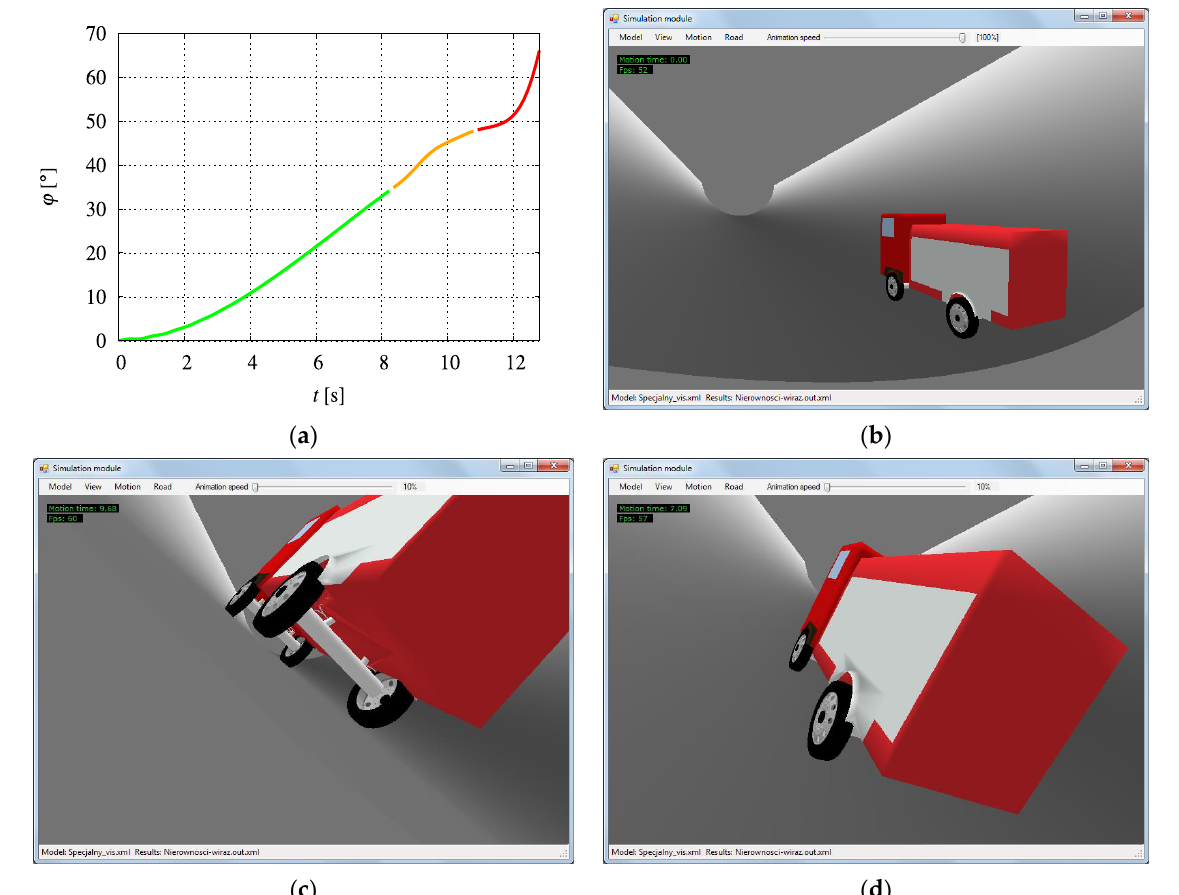
Figure 23. The example of simulation of stability loss: ( a ) three phases of rollover maneuver, ( b ) beginning of computer simulation, ( c ) rollover started, ( d ) rollover.